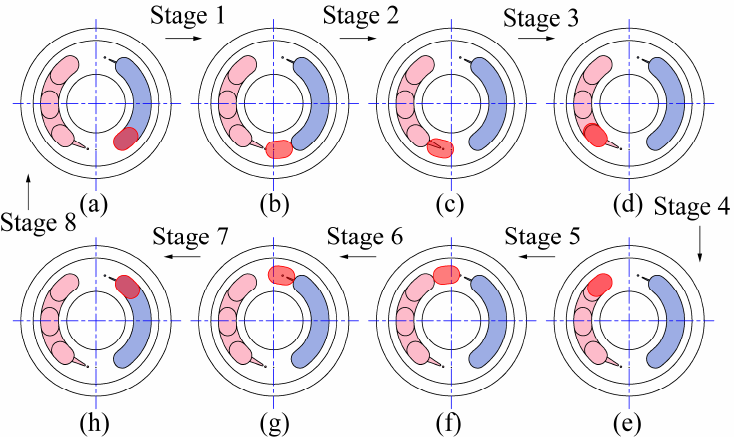
Figure 20. Working stages of the piston chamber: ( a – h ) critical positions between work stages.